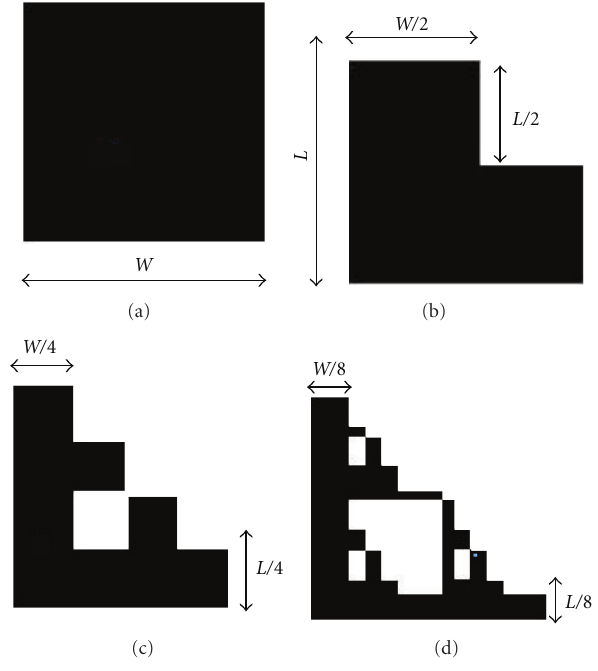
Figure 1: Self-a ffi ne fractal structure. (a) initiator S1; (b) first iteration S2; (c) second iteration S3; (d) third iteration